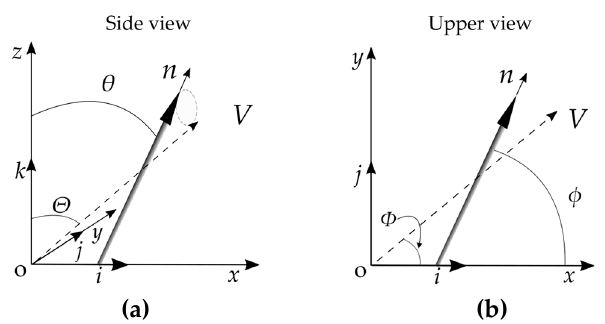
Figure 2. ( a ) Side and ( b ) upper views from an arrow in free